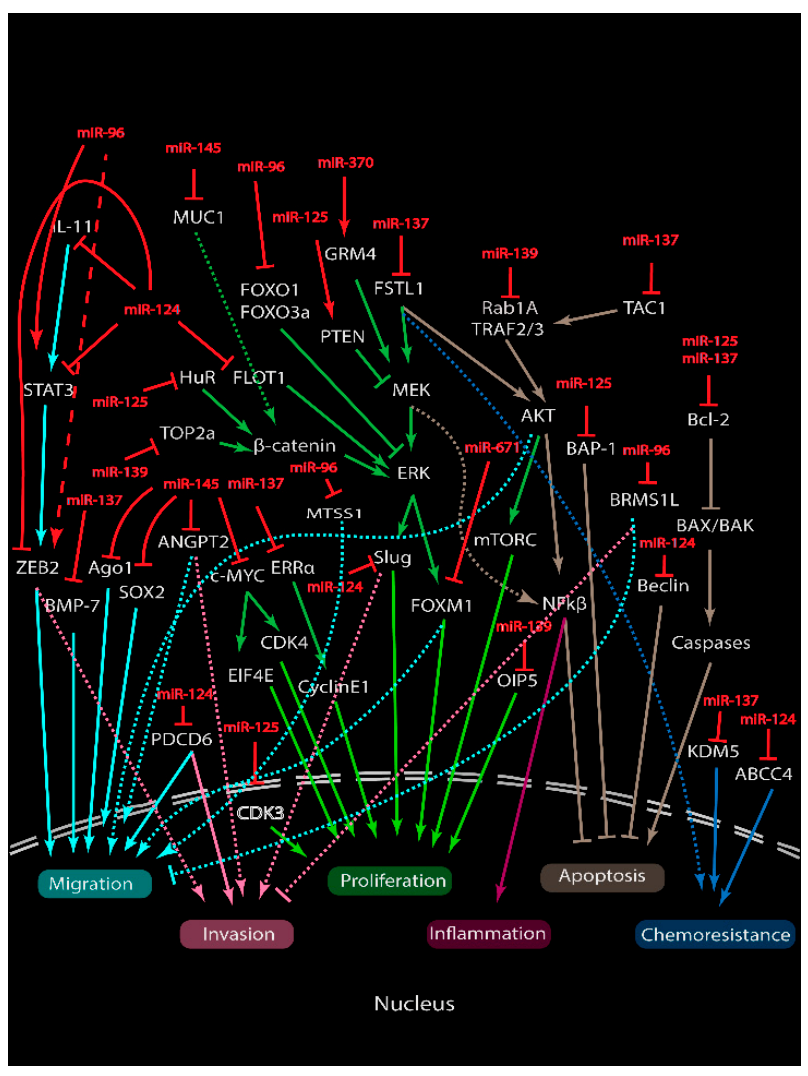
Figure 4. Roles of miRNA in cell signaling regulating tumorigenesis. Oncogenic miR ‐ 370 upregulates GRM4 expression and miR ‐ 96 regulates the expression of FOXO, MTSS1, BRMS1L and ZEB1 proteins. Both resulted in the promotion of proliferation and invasion. Tumor suppressive miR ‐ 124, miR ‐ 125, miR ‐ 137, miR ‐ 139, miR ‐ 145 and miR ‐ 671 can suppress oncogenic targets and inhibit cancer progression. miR ‐ 124 can bind Slug, STAT3, ZEB2, PDCD6, Beclin ‐ 1, FLOT1, IL ‐ 11 and ABCC4. miR ‐ 125 can interact with HuR, BAP ‐ 1, PTEN, Bcl ‐ 2 and CDK3. miR ‐ 137 targets FSTL1, BMP ‐ 7, ERR α , Tac1 and KDM5. miR ‐ 139 can binds TOP2a, RAB1A and OIP5. miR ‐ 145 directly inhibits MUC1, ANGPT2, c ‐ Myc, Sox ‐ 2 and Ago1. miR ‐ 671 regulates FOXM1 expression. All, in turn, result in the regulation of cancer progression by suppressing the cancer hallmarks including chemoresistance.